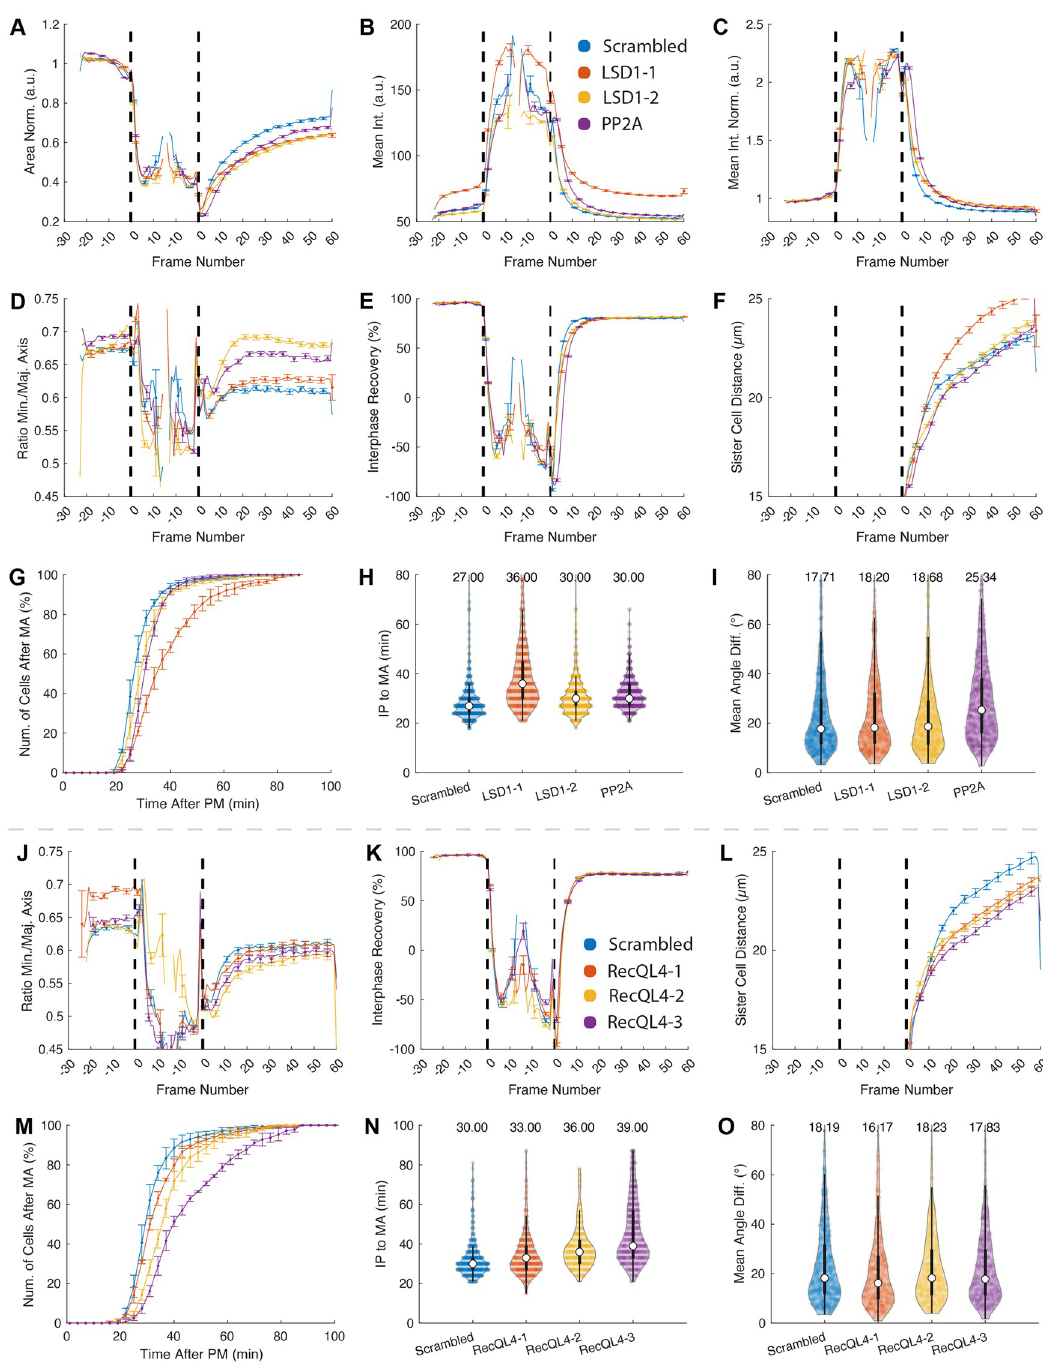
Fig 5. Analysis of PP2A (Positive control), LSD1 and RecQL4 knockdowns. Panels (A)-(I) show control (Scrambled) vs. LSD1–1, LSD1–2 and PP2A, whereas panels (J)-(O) show control (Scrambled) vs. RecQL4–1, RecQL4–2 and RecQL4–3 knockdown cells. The features involve the normalized area (A), the mean intensity (B), the normalized mean intensity (absolute intensity values divided by the interphase mean intensity of each cell, C), the minor axis vs. major axis ratio (D, J), the interphase recovery ratio (E, K), distance between sister chromatin masses (F, L) and cumulative histograms for the time in early mitotic progression until anaphase onset (G, M). The violin plots show the duration between interphase-prophase and meta-anaphase transition in minutes (H, N) and the mean angular difference in degrees (I, O). Images of panels (A)-(I) were acquired with a confocal microscope (LSM5L, 10 × , 0.656 μm /pixel). The plots combine extracted trajectories from three independent repeats with a total number of N Scrambled = 1262, N LSD1-2 = 970, N LSD1-6 = 1332, N PP2A = 1198 cells. Images of panels (J)-(O) below the dashed line were acquired